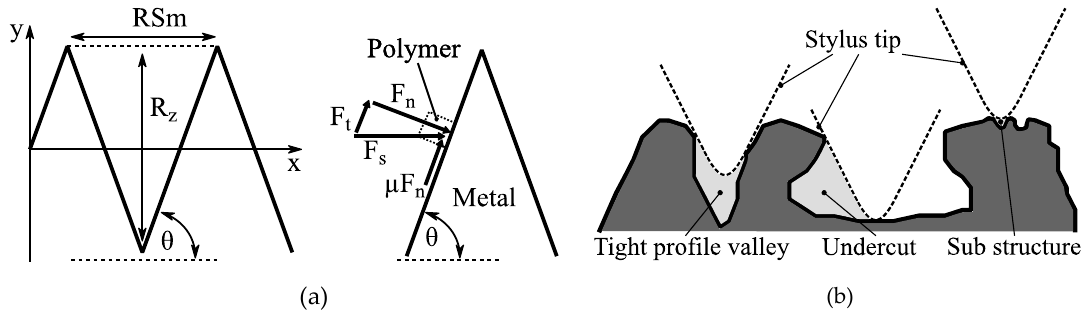
Figure 6. Surface roughness profile: ( a ) schematic representation and resulting forces and ( b ) not considered profile elements.